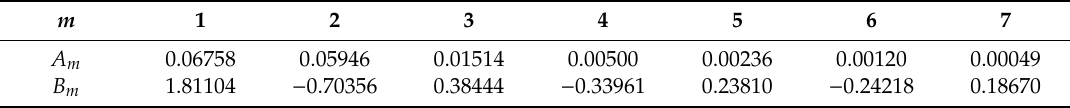
Table 5. The values of the coefficients 𝐴 (cid:3040) and 𝐵 (cid:3040) of the solution 𝑢 ((cid:2875)) (𝑥, 𝑡) (see Example 3).